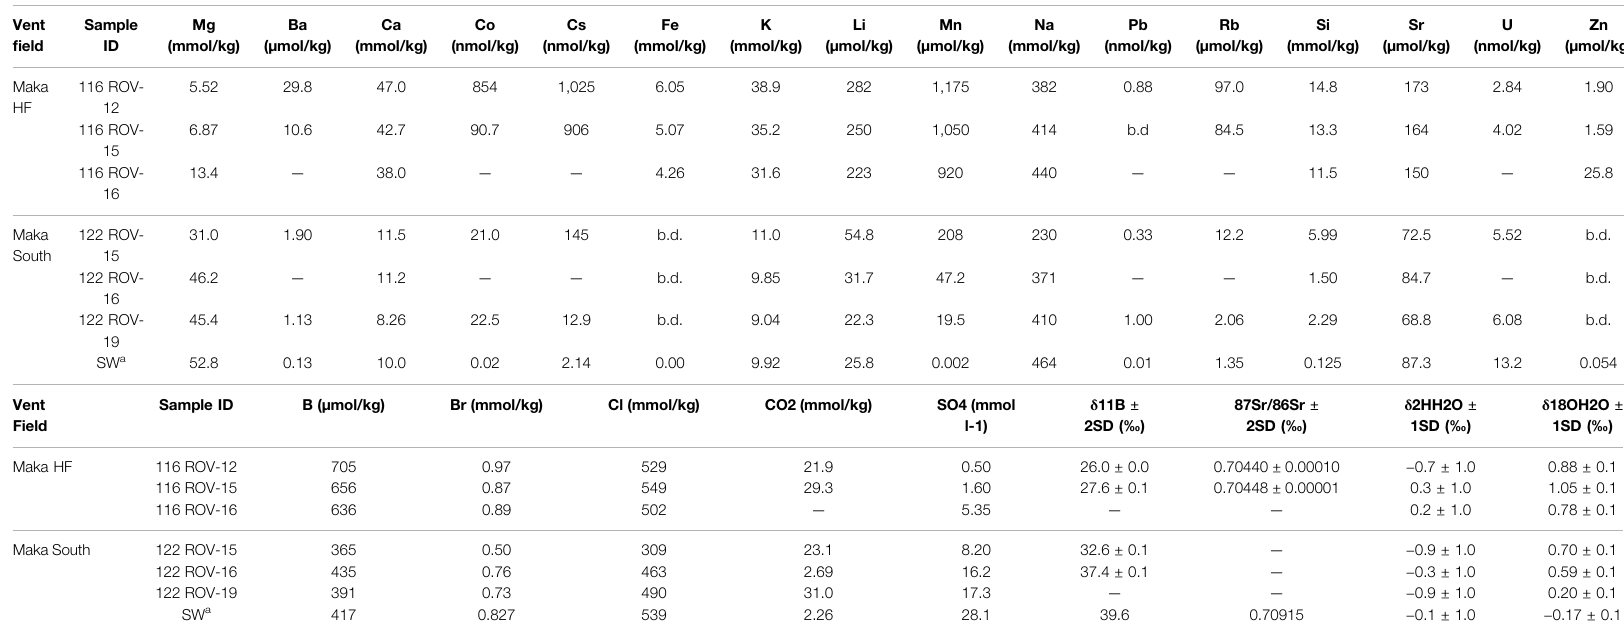
TABLE 2 | Major, minor and trace element data together with gas concentrations and stable and radiogenic isotopes in the vent fl uids from Maka HF and Maka South. Notation: b.d.: below detection limit. Vent Sample fi eld ID Maka HF